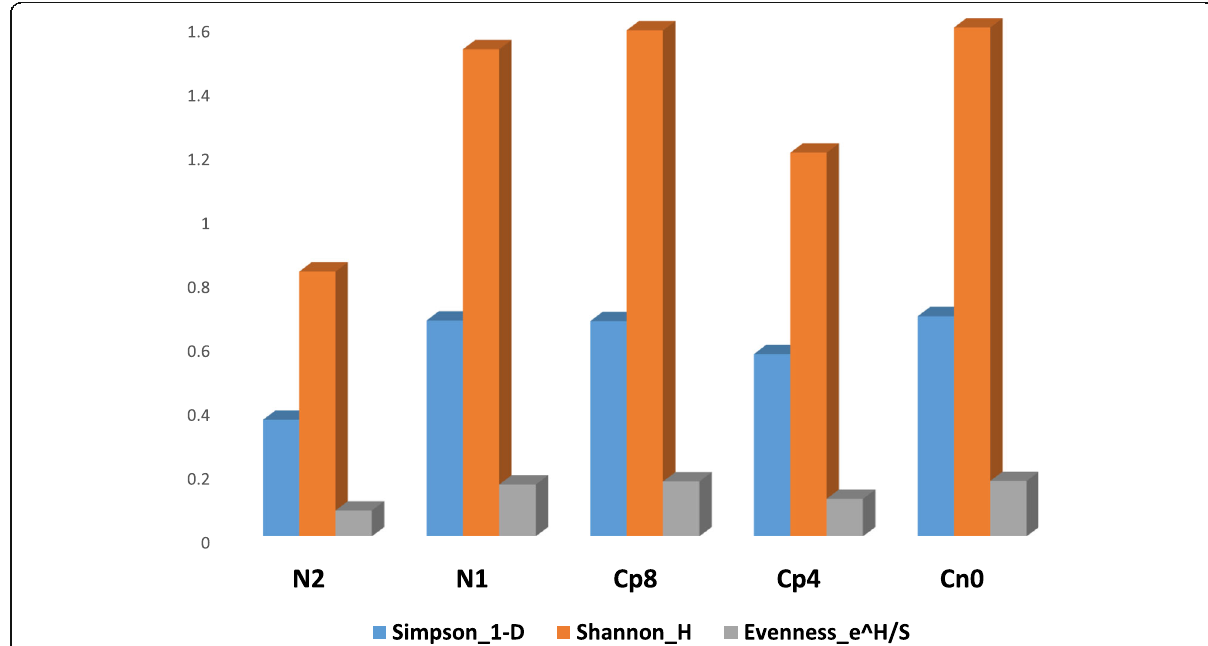
Fig. 7 Diversity indices for bacterial phylum within the maize rhizosphere treated with organic and inorganic fertilizer as well as under control condition. Cn0 (control), N1 (60 kg/ha NPK), N2 (120 kg/ha NPK), Cp8 (8 tons/ha compost), and Cp4 (4 tons/ha compost